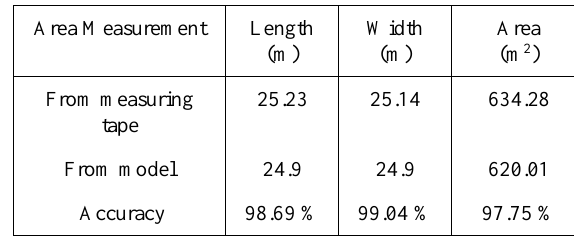
Table 3. Comparison of area obtained from different